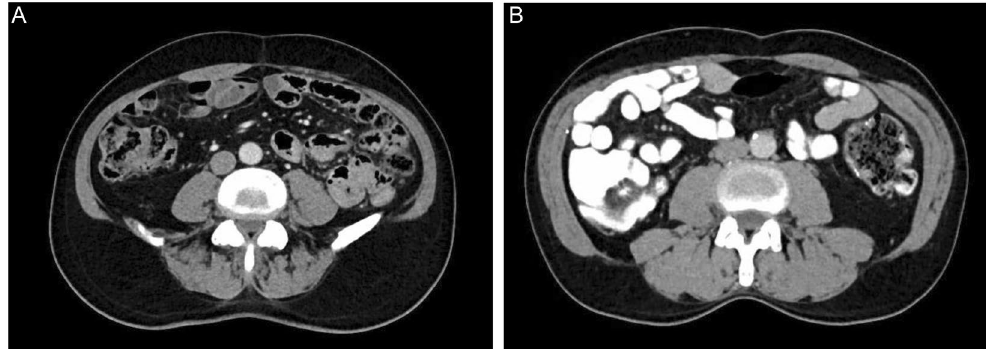
Figure 3. CT images of two patients with either water only or Télébrix Gastro as oral contrast. ( A ) shows an axial image of an abdominal CT of a 72-year-old man with metastatic renal cell carcinoma where the gastrointestinal tract was filled with water only (grey lumen). ( B ) shows an axial image of an abdominal CT of a 65-year-old man colorectal liver metastasis where the gastrointestinal tract was filled with Télébrix Gastro (white